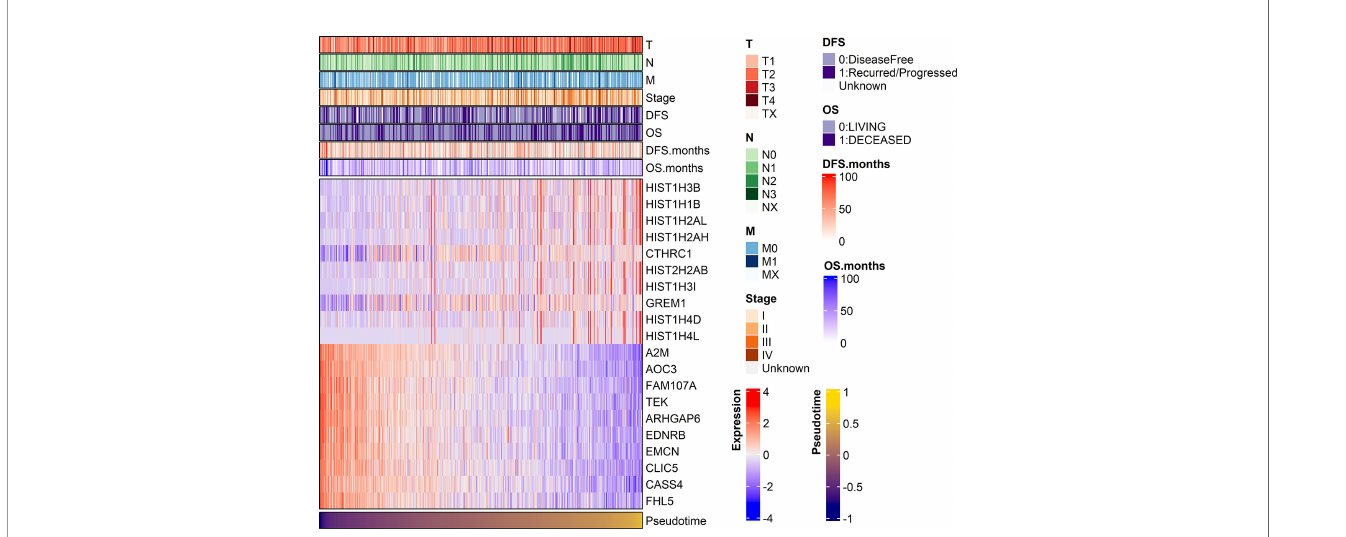
FIGURE 1 | A heatmap visualizing clinical features and gene expression along pseudotime in the TCGA-LUAD dataset. Clinical features, including TNM stage and the expression of the top 10 genes showing signi fi cant positive or negative associations with pseudotime, are displayed. In particular, histone-coding genes showed signi fi cant upregulation over